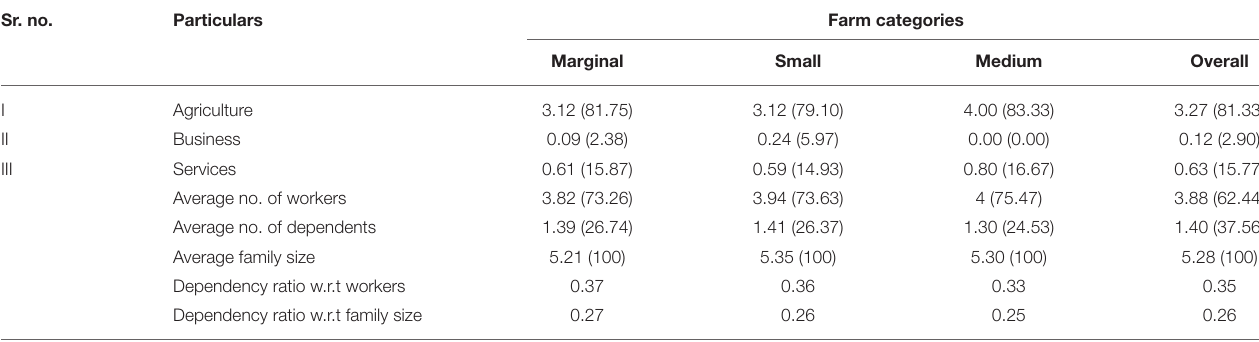
TABLE 5 | Farm category-wise occupational distribution of the sampled households (No.). Sr. no.